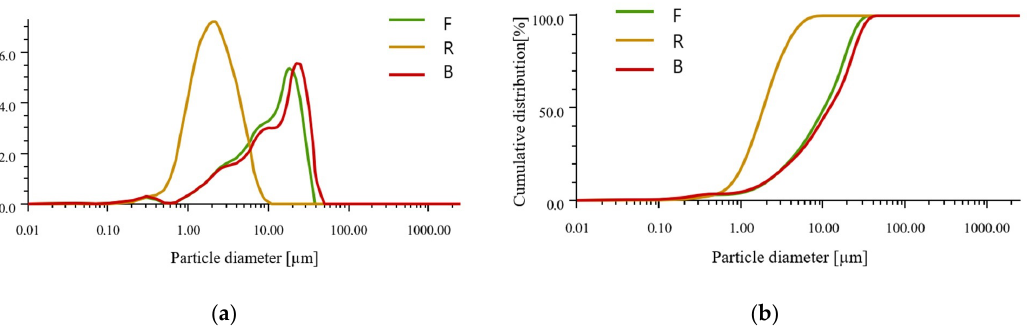
Figure 2. Results of particle size analysis: ( a ) Particle size distribution histogram; ( b ) cumulative particle size distribution curves. Table 1. Particle size distribution in different